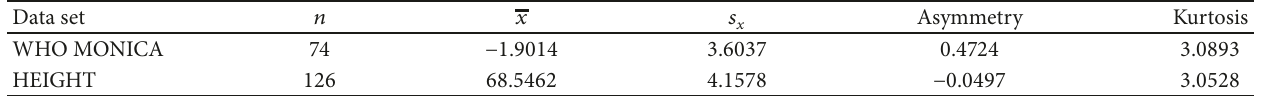
Table 3: Descriptive summary.